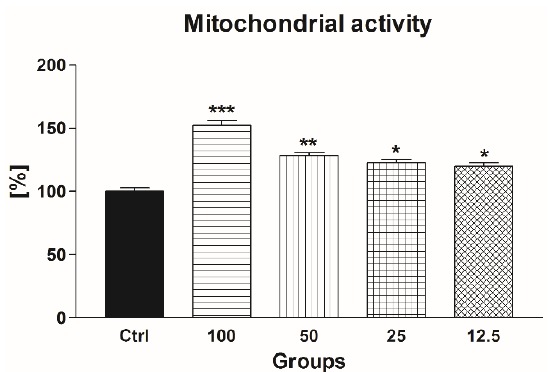
Figure 7. The effect of epicatechin (EPI; μ mol/L) on the mitochondrial activity of frozen-thawed bovine spermatozoa. * p < 0.05; ** p < 0.01; *** p < 0.001.